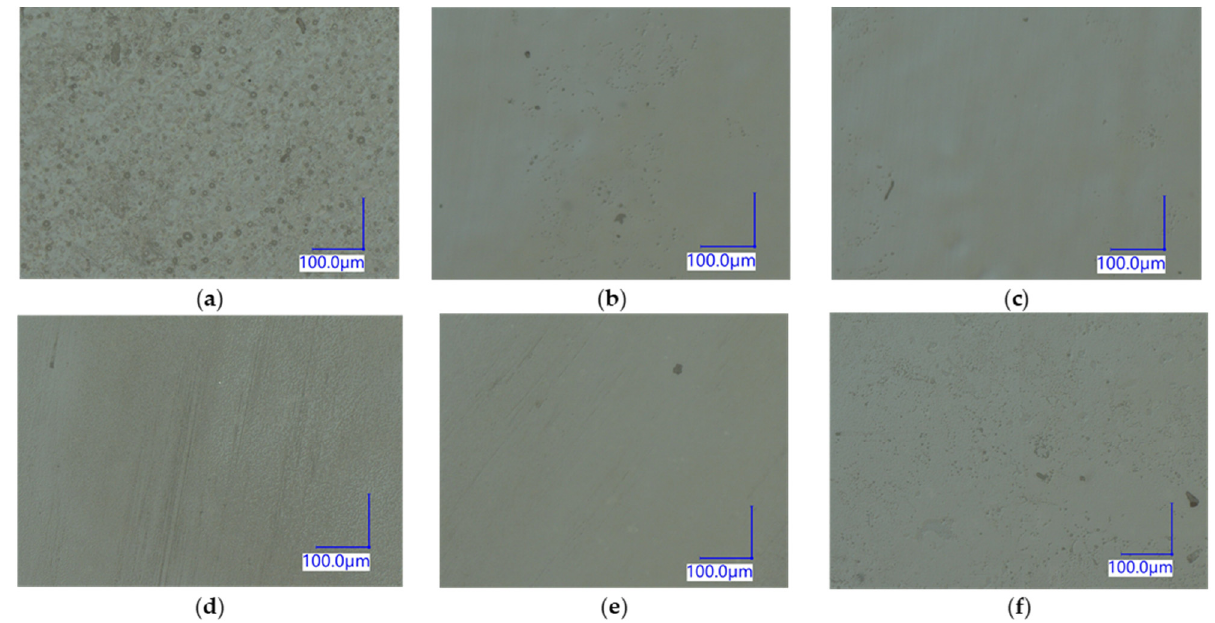
Figure 2. Representative cross-section micrographs for ( a ) UL5, ( b ) UL6, ( c ) UL7, ( d ) EbS-1, ( e ) EbS- 2, and ( f ) EbS-3. The images show a clear interface between the substrate and the coating layer.